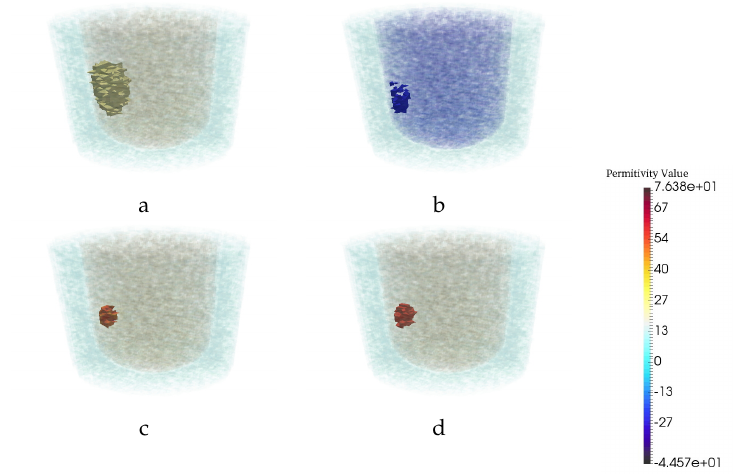
Figure 6. Reconstruction results for a particular example with one tumor at 1.05 GHz. The real ( a ) and imaginary ( b ) part of CSI reconstruction. ( c ) CNN reconstruction. ( d ) Ground